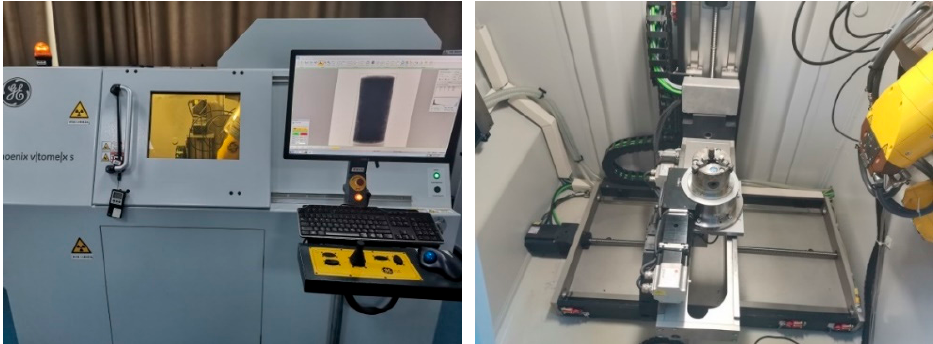
Figure 5. Phoenix v|tome|xs high ‐ precision industrial CT: ( left ) Scanning equipment; ( right ) Sam ‐ ple Placement.